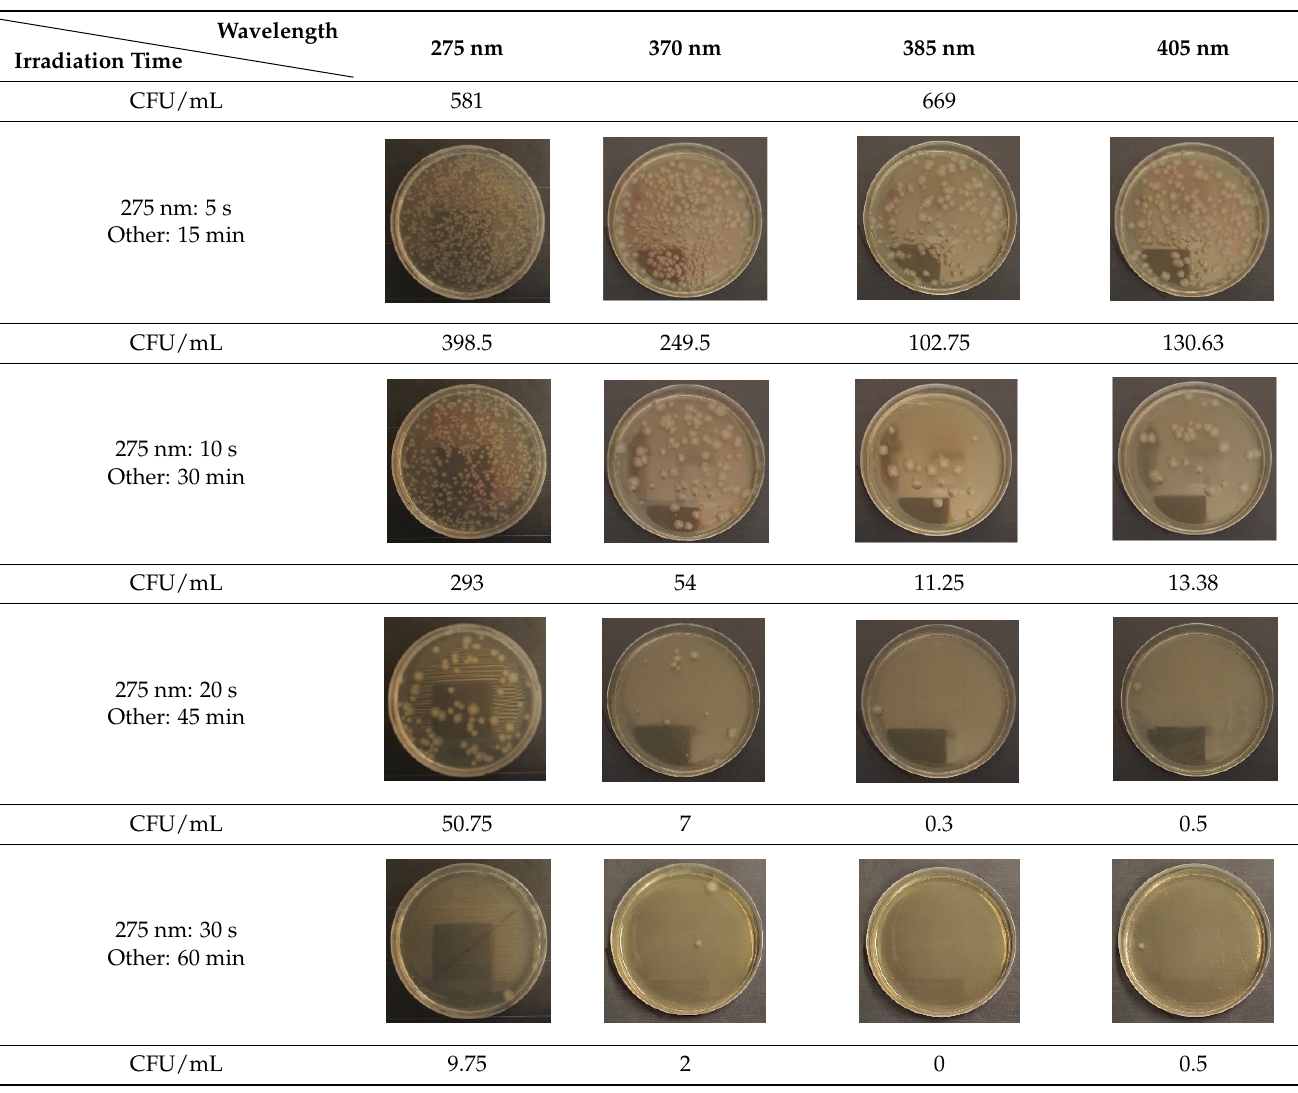
11 of 19 Figure 5. Inactivation curves of E. coli at each dose and wavelength: ( a ) 370, 385, and 405 nm; ( b ) 275 nm. Table 5. Numbers of E. coli colonies by wavelength and irradiation time.